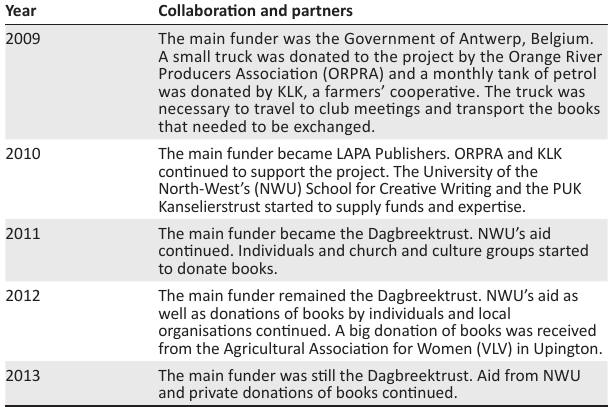
TABLE 4: Themes identified from monthly and yearly reports and field notes: Collaboration and partners.